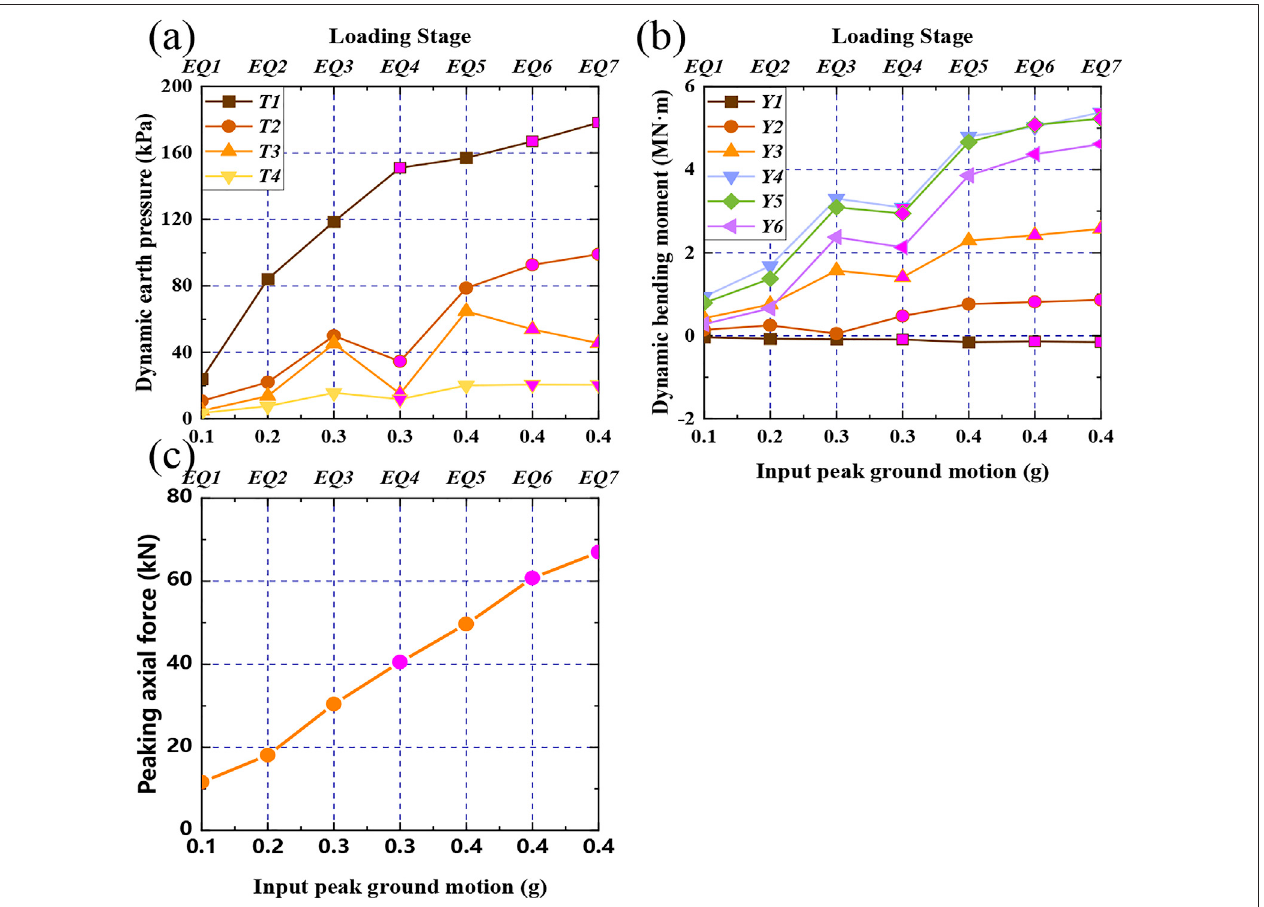
FIGURE 5 | Variation curve of the peak value of pile dynamic behavior with input ground motion intensity: (A) The peak dynamic earth pressure of the pile; (B) The peak dynamic bending moment of the pile; (C) The peak axial force of the anchor cable.